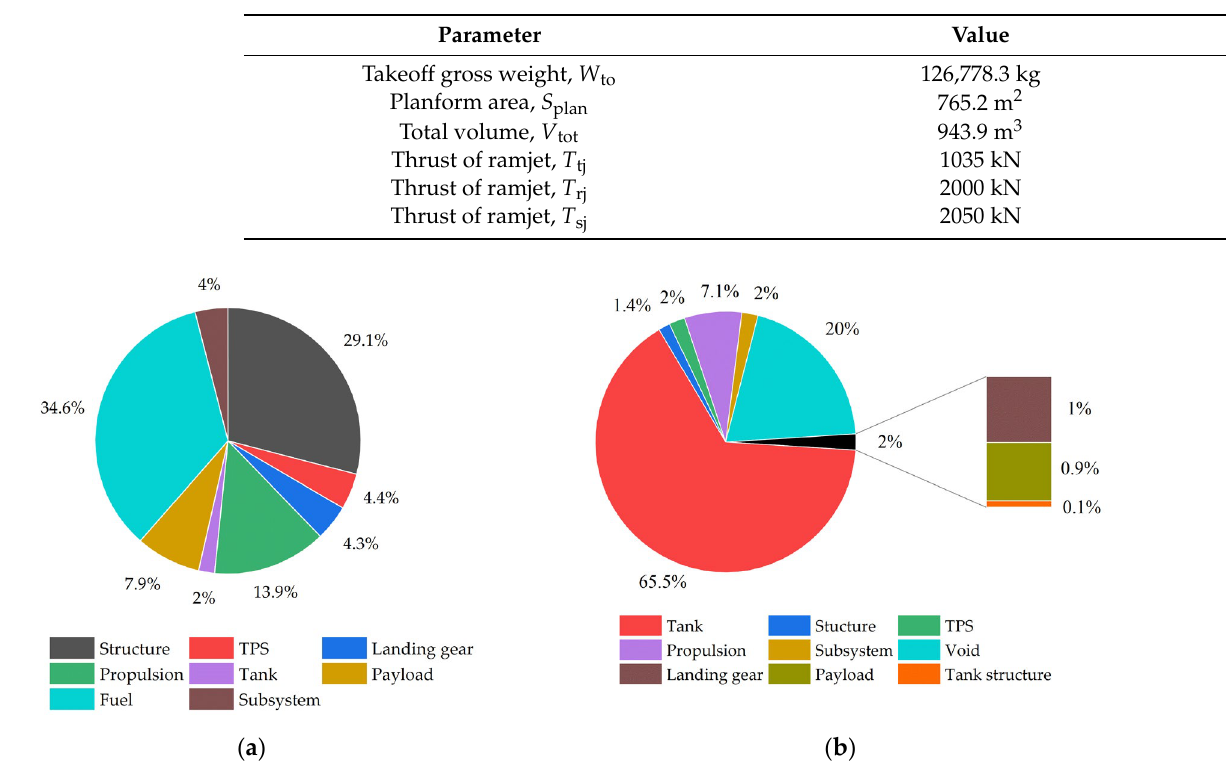
Table 2. The estimated takeoff gross weight, total volume, and thrust.